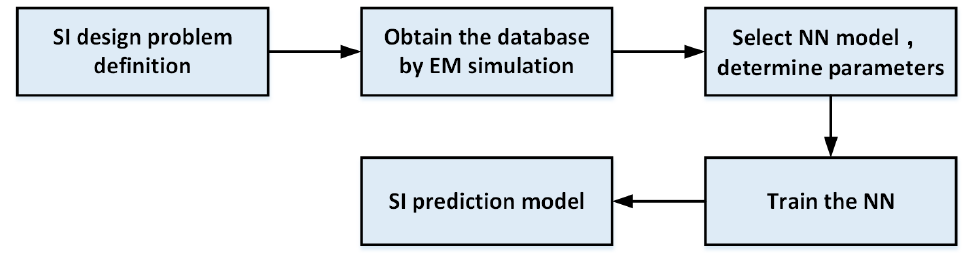
Figure 2. Flow chart of SI prediction model of microsystem constructed by